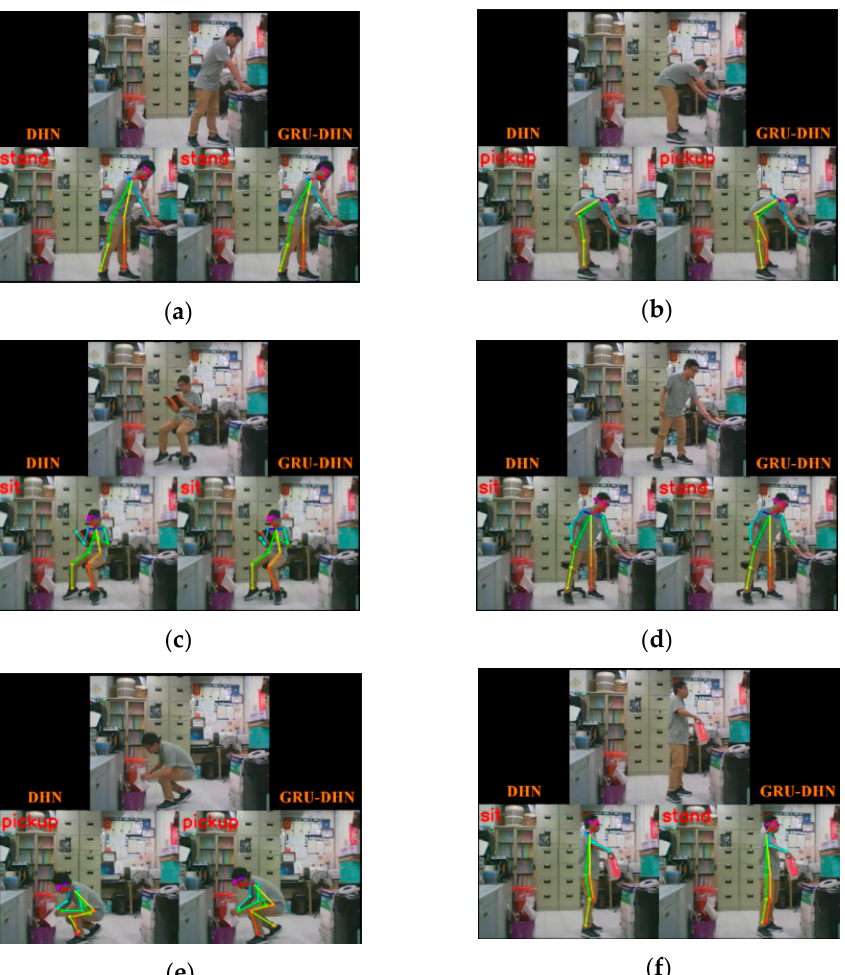
Figure 12. Online continuous testing of the behavior-recognition model. ( a ) Stand motion at 23 s ( b ) Pick up motion at 33 s ( c ) Sit motion at 40 s ( d ) Stand motion with different prediction result at 57.5 s ( e ) Pick up motion at 78 s ( f ) Stand motion with different prediction result at 85.5 s (sec).